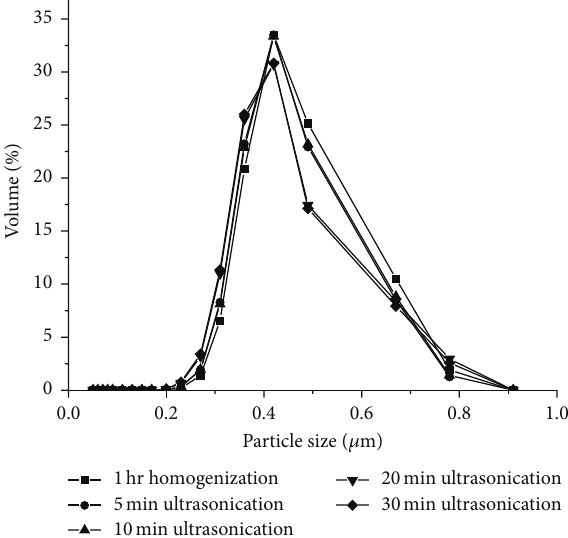
Figure 4: Particle size distribution of AEROSIL OX 50 (1% aqueous dispersion) measured after sonification for various duration using Mastersizer. The error percentage was about 3.5%.